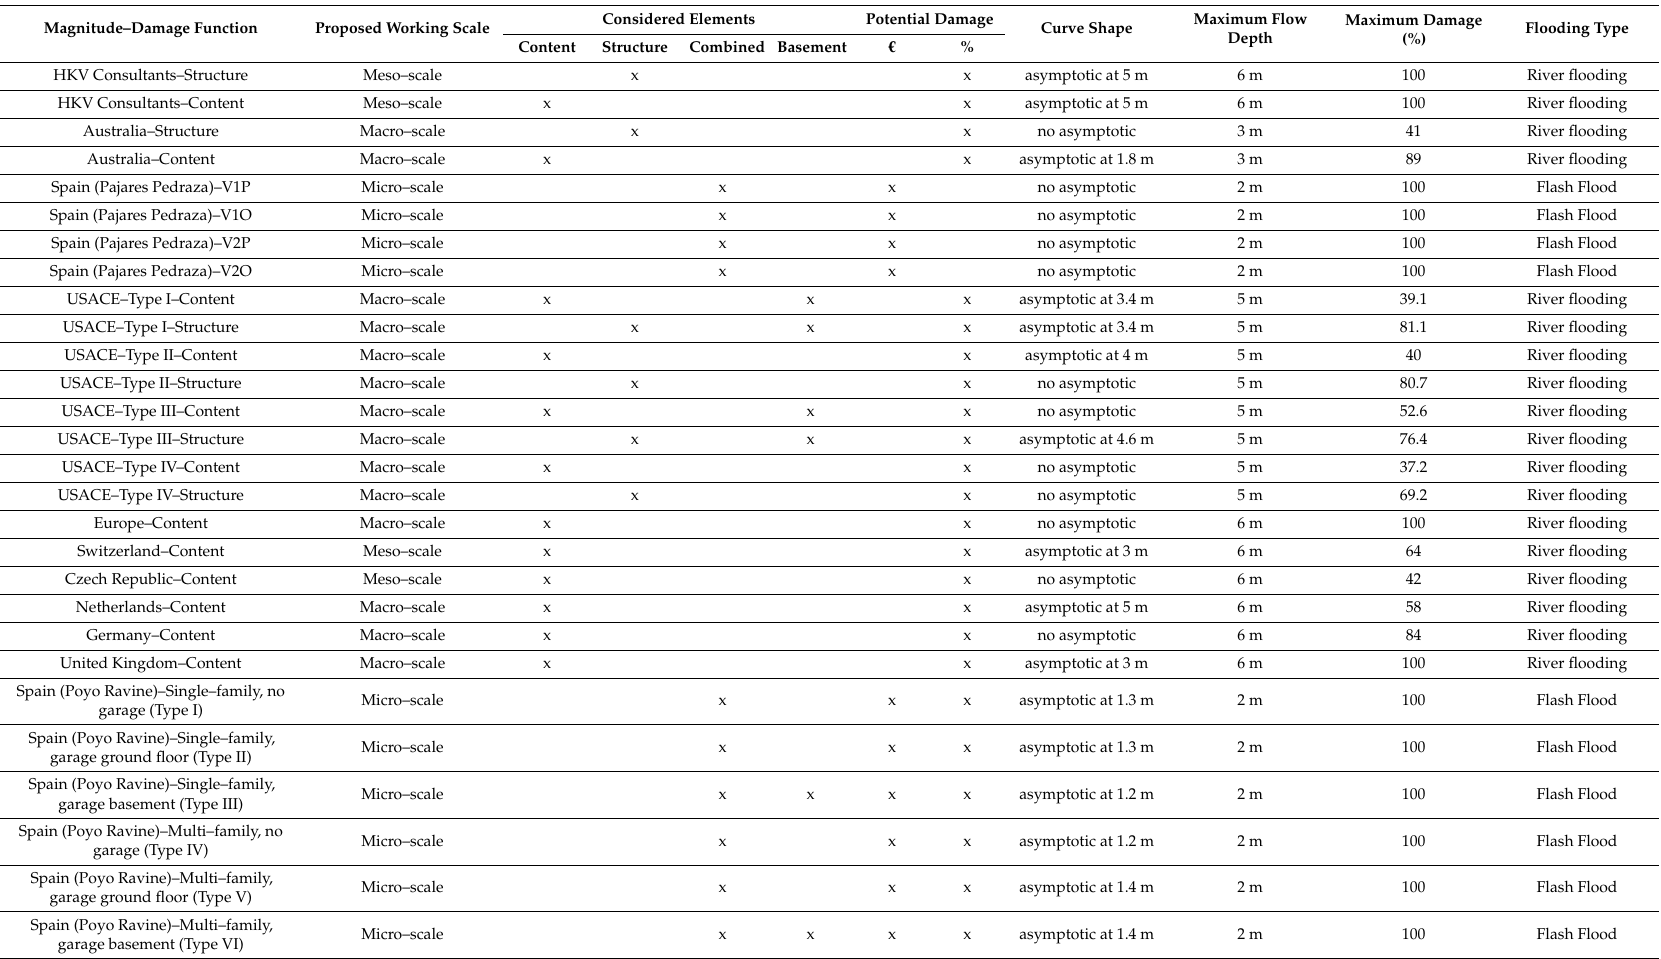
Table 1. List of magnitude–damage models and their main